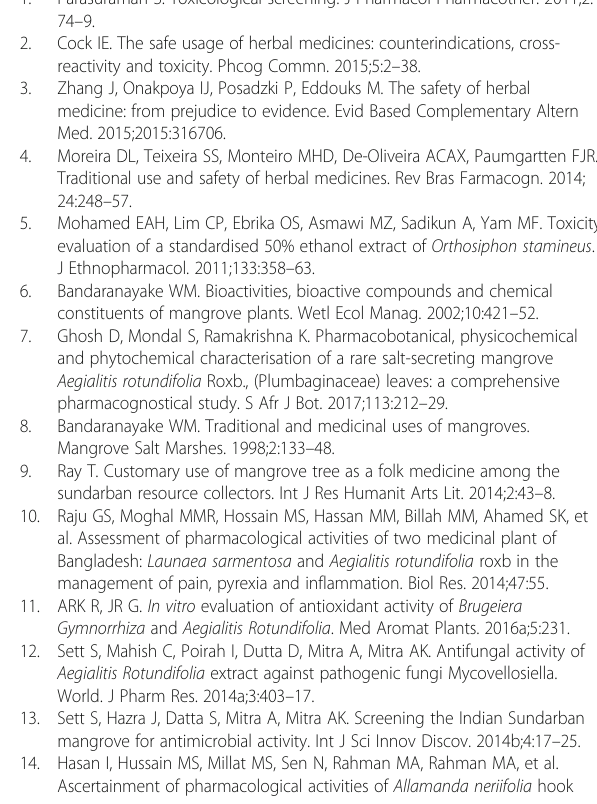
Additional file 1: Table S1. Urine analysis of male rats treated with ARELE at different doses for a period of 30days. Table S2. Urine analysis of female rats treated with ARELE at different doses for a period of 30days. Table S3. Functional Observational Battery (FOB) scores for neurotoxicological investigation. Table S4. Effects of ARELE on behavioural endpoints of the FOB on initial week (Day 0). Table S5. Effects of ARELE on behavioural endpoints of the FOB on final week (Day 30). (DOCX 37